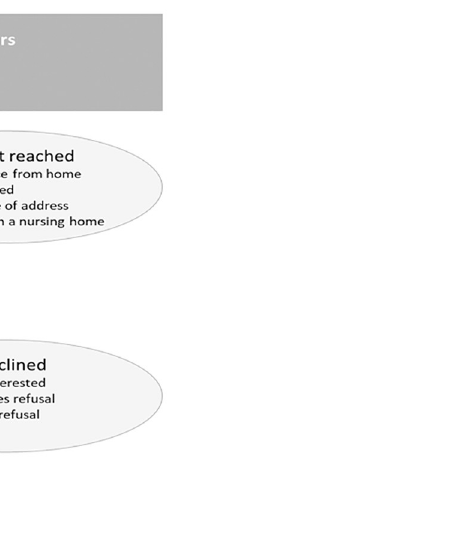
Fig 1. MADRID+90